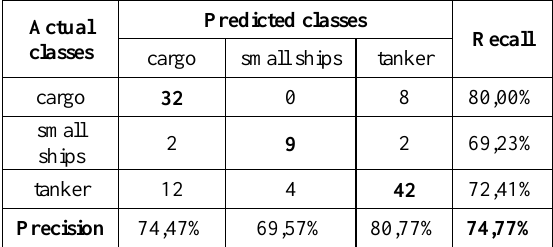
Figure 7. Feature stability results.